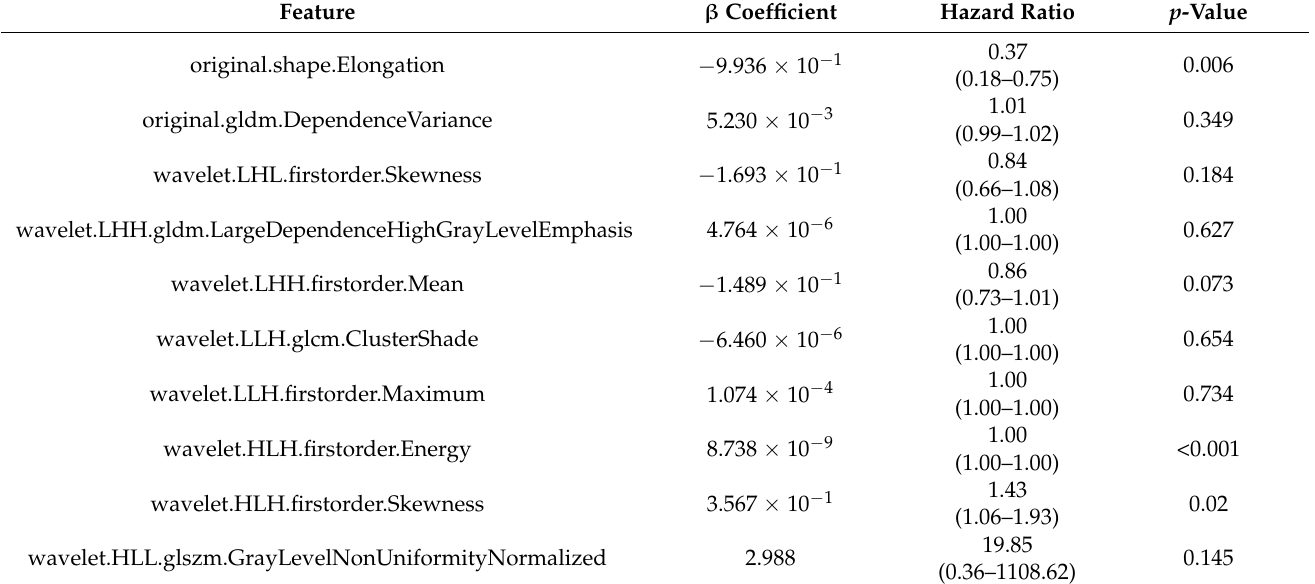
Figure 2. Risk score distribution and ten features radiomics signatures expression by Multivariate COX regression in the training set. ( A ) Risk score distribution. ( B ) Scatter plot divide patients into two groups: low-risk group (steel blue color) and high-risk group (tomato red color). ( C ) Expression heat map of 10 radiomics signatures in the training set. Table 3. Multivariate Cox regression analysis of ten radiomics signatures in the training